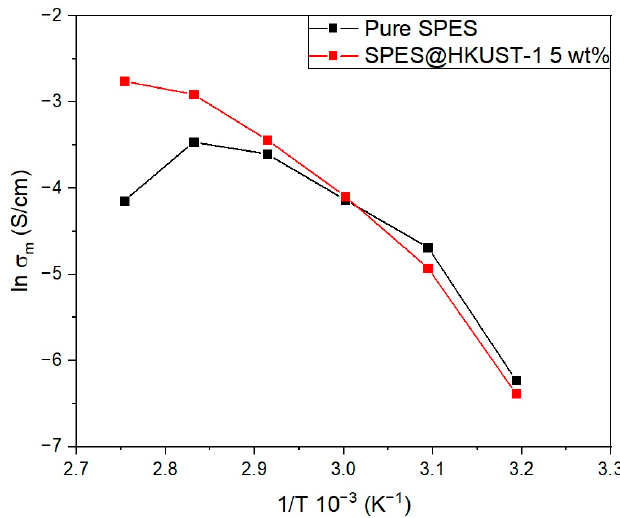
Figure 8. Proton conductivity of the pristine SPES membrane and the SPES@HKUST-1 with HKUST-1 loading of 5 wt. %, as a function of temperature at 90% RH.